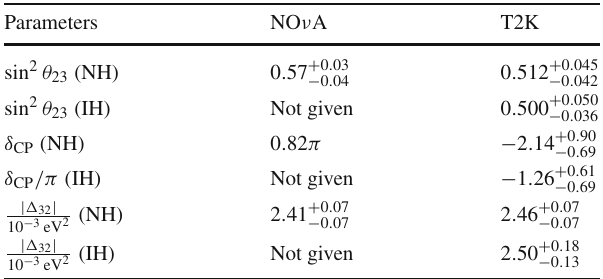
Table 1 Best-fit values of neutrino oscillation parameters as measured by NO ν A [17,18] and T2K [19,20]